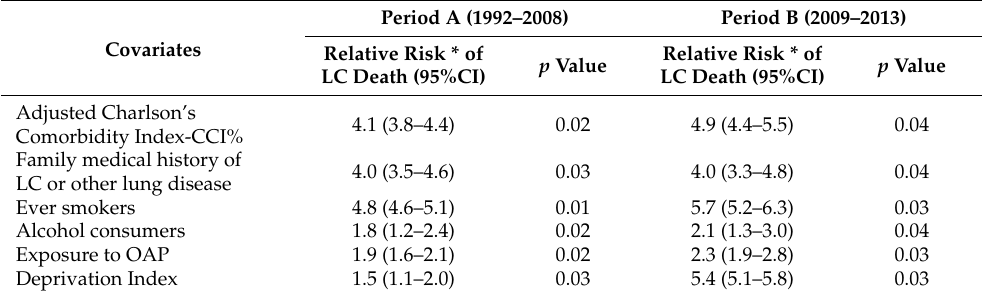
Table 2. Multiple predictors of LC mortality before and after the economic crisis, ( n = 3599).